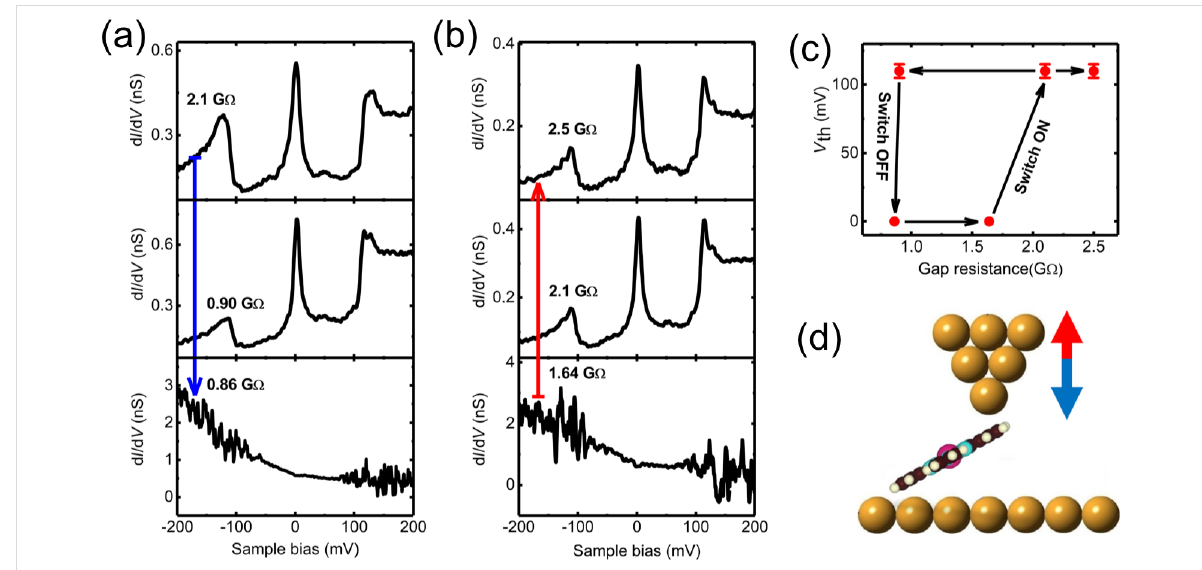
Figure 4: d I /d V spectra of the MnPc molecular junction with (a) decreasing and then (b) increasing gap resistance, respectively. The gap resistance is controlled by adjusting the sample bias voltage from − 250 over − 108 to − 103 mV, first, and then from − 197 over − 250 to − 300 mV, while the tunnel- ing current is kept constant at 0.12 nA. (c) Variation of the satellite peak threshold voltage as a function of the gap resistance in (a) and (b). (d) Schematic view of the molecular junction. The blue and red arrows indicate decreasing and increasing gap resistance or tip height with respect to the